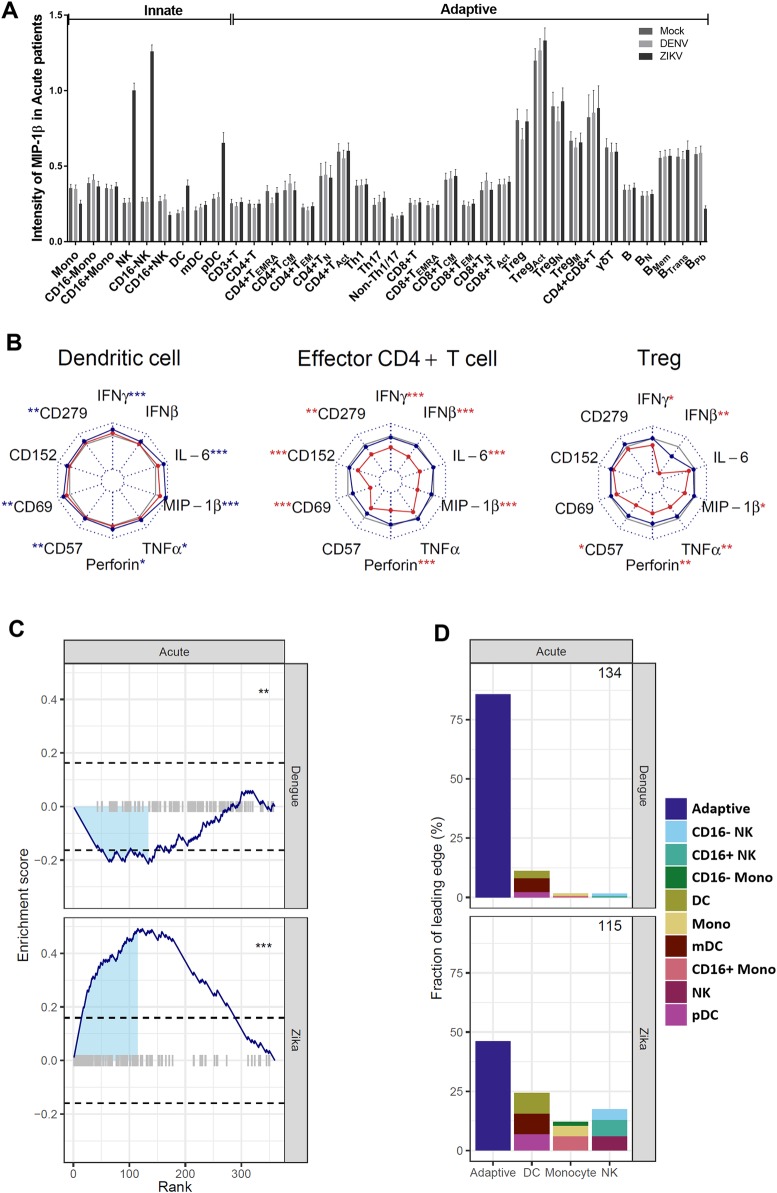
Response to Zika and dengue infection in vitro.PBMCs from acute subjects (n = 30) were incubated with medium alone (mock) or infected in vitro with dengue virus (MOI = 10) or Zika virus (MOI = 5) for 24 h and labeled with metal-conjugated antibodies for mass cytometry. (A) Levels of MIP-1β detected in 36 cell subsets from PBMCs untreated (mock) or stimulated with dengue or Zika virus. (B) For each cell type, proportional changes in 10 activation markers and cytokine levels were quantified comparing mock to the level post-infection with dengue (red lines) or Zika (blue lines) by log2 of the fold-change (infected/mock). The range of plotted fold-changes is indicated at the center and top of each radar plot, with no change (i.e., log2(fold-change) = 0) indicated by the solid grey line. Significant changes are indicated adjacent to each cytokine/activation marker with * p<0.05, ** p<0.01 and *** p<0.001 and color indicates whether the change was significant following incubation with dengue (red *) or Zika (blue *). (C) Each of the 360 cell type/functional marker combinations were rank-ordered by P value (lowest to highest along the x-axis) comparing virus-induced changes with dengue (top panel) or Zika (bottom panel). Enrichment scores for innate cell types were calculated as a running sum (solid blue lines), with comparisons involving innate cell types indicated by grey bars (plotted along the x-axis at an enrichment score of 0). The maximum absolute enrichment score was used to define the “leading edge” (light blue shaded area), and significance of this score was determined by random permutation of cell type labels within each cytokine (horizontal dashed lines indicate the 95% confidence interval). Significance is indicated as: ns (not significant), * p < 0.05, ** p < 0.01, *** p < 0.001. (D) The relative contribution of adaptive and innate cell types to the leading edge of Fig 4C for infection-induced changes with dengue (top panel) or Zika (bottom panel). The number of cell type/functional marker combinations included in the leading edge is indicated in the upper right of each panel.